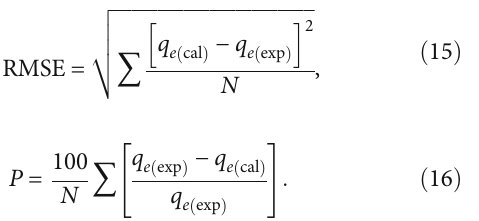
tabulated in Table 4. The lowest values for both RMSE and P for second-order kinetics support its appropriateness and fi tness over fi rst-order kinetics [76].